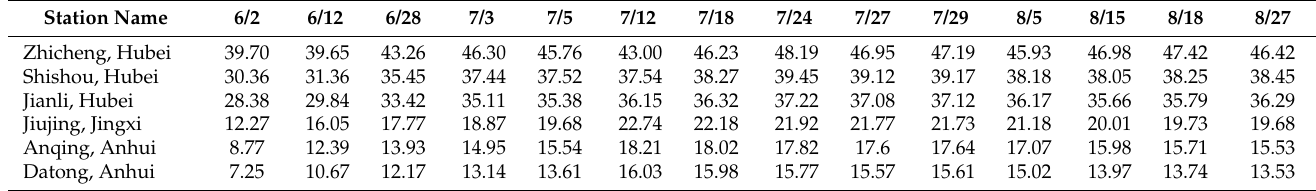
Table 1. Water level for middle reaches of the Yangtze River (unit: meter).